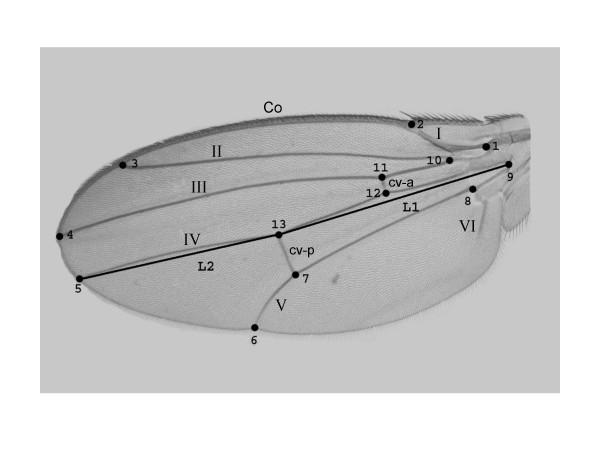
Left wing of Drosophila subobscura The image shows the thirteen landmarks (1 – 13) used in this work. I – VI longitudinal veins; cv-a and cv-p anterior and posterior crossveins; Co costal or marginal veins; L1 and L2 lengths of the proximal (Euclidian distance between landmarks 9 and 13) and distal (Euclidian distance between landmarks 13 and 5) segments of longitudinal vein IV, respectively. Wing shape index  has been previously used to study shape clines in this species [30].